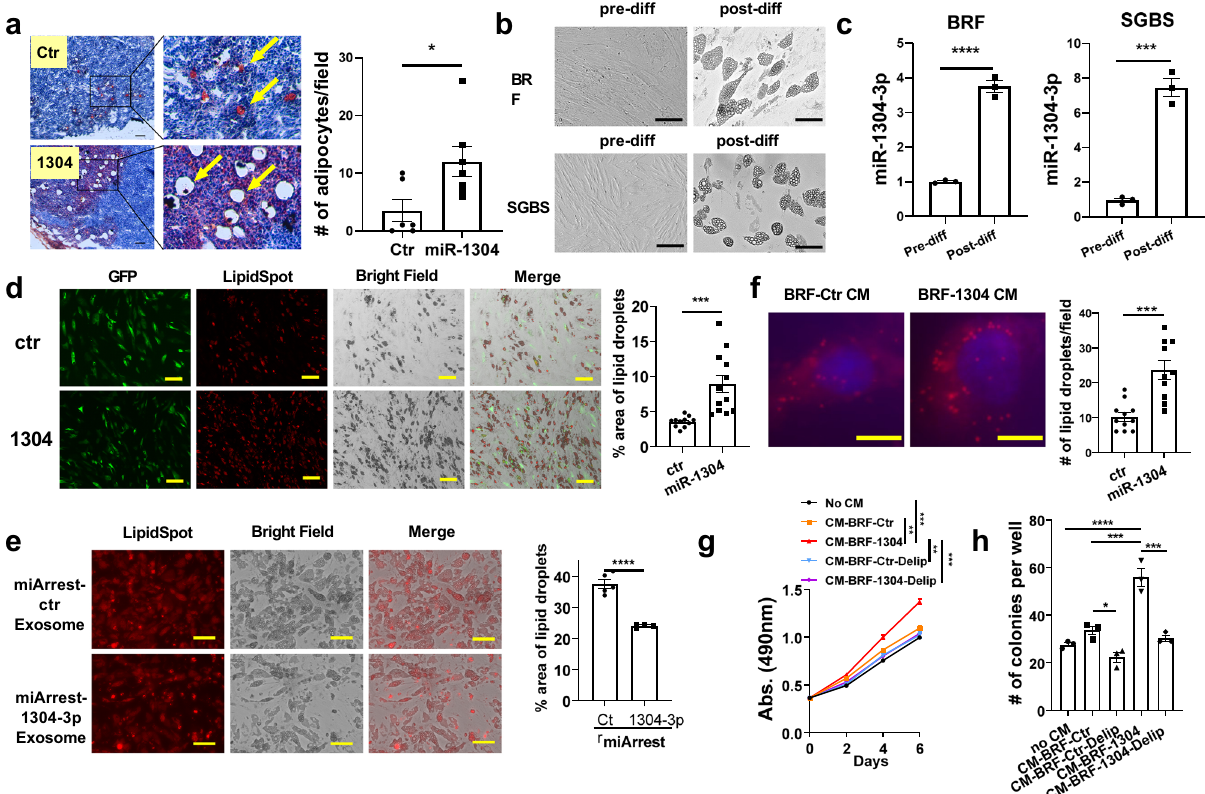
Fig. 3 | miR-1304-3p promotes cancer-associated adipocytes. a Tumor cryo- sections were stained with Oil Red O and hematoxylin. Arrows indicate cancer- associated adipocytes. Shown on the right is the number of adipocytes per fi eld from 6 (control) or 7 (miR-1304) random 40X fi elds (unpaired two-tailed student t test, p = 0.0271). Scale bar =100 μ m. b Representative fi gures showing pre and